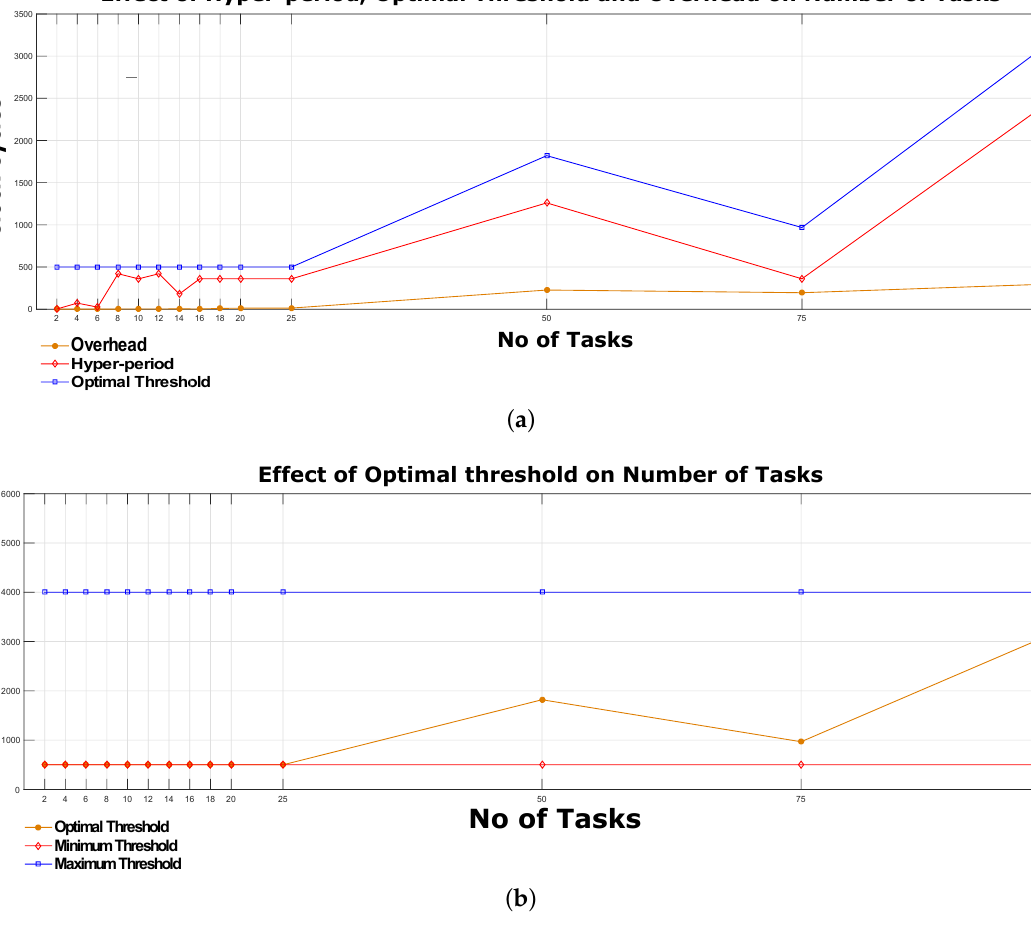
Figure 7. Scenario 1: The effect of varying Number of Input Tasks, given Period = 1–10, Execution Time Range = 1–5, Arrival Time Range = 1–5. ( a ) effect of hyper-period, optimal threshold and overhead on number of tasks; ( b ) effect of optimal threshold on the number of